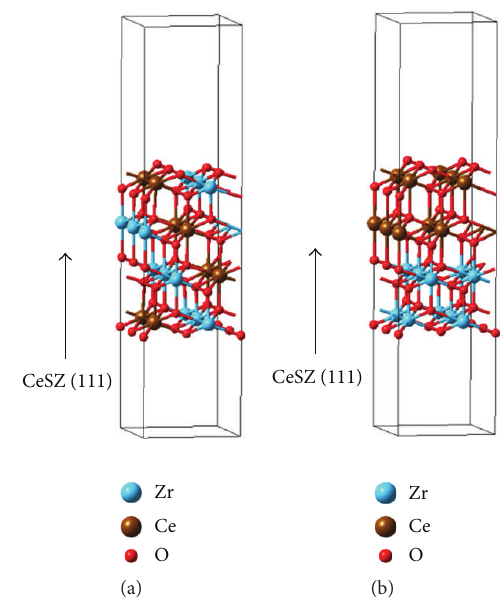
Figure 2: Schematic illustration of the (a) Ce-segregation-free and (b) Ce-segregated CeSZ (111) surface used for